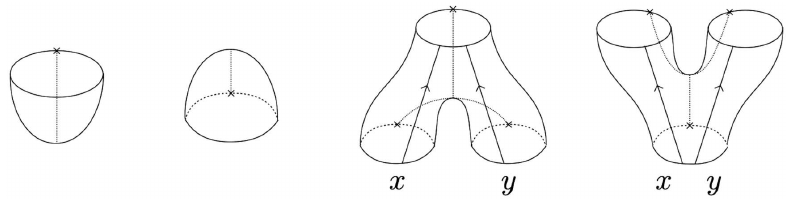
Figure 8 . The above figures represent the basic elements of the transition amplitude for a general surface: from left to right, the unit, the counit, the multiplication, and the comultiplication.